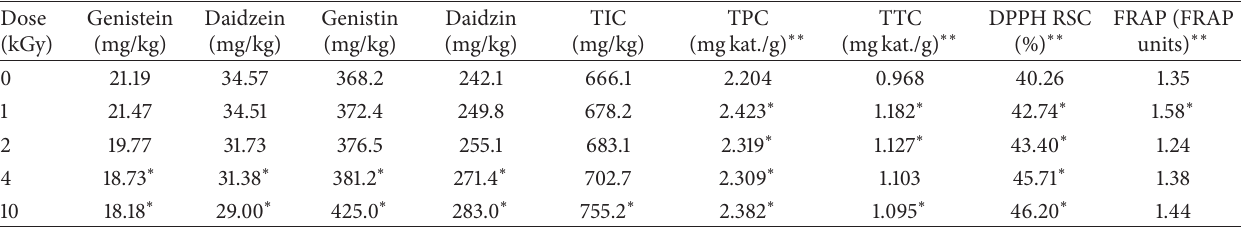
Table 1: Effect of different doses of gamma irradiation on isoflavone (genistein, daidzein, genistin, and daidzin), total phenol and tannin contents, DPPH RSC, and FRAP of soybean